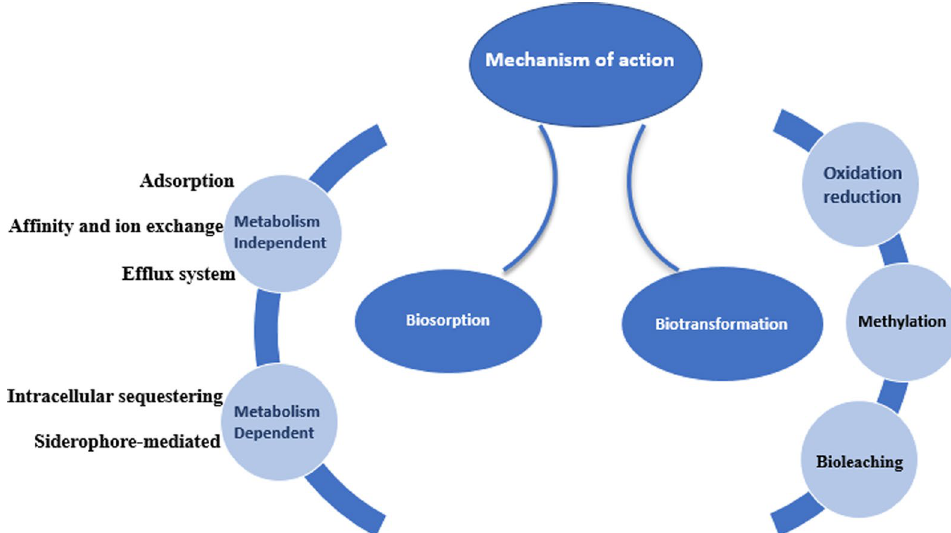
Fig. 2 Diagram showing different mechanisms of bioremediation